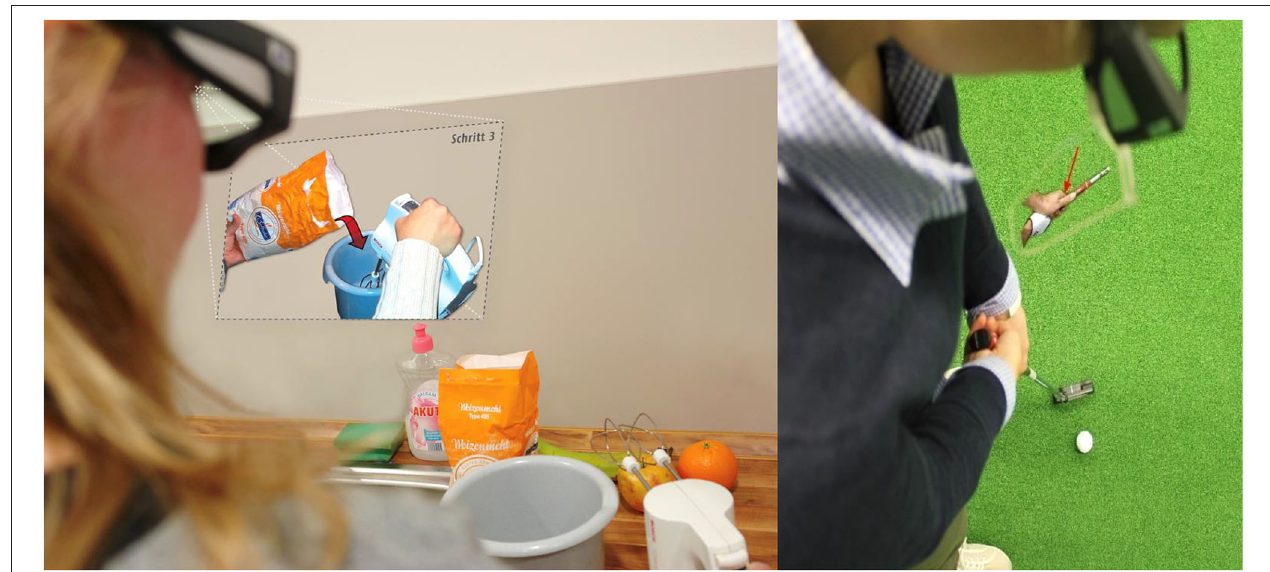
FIGURE 6 | Based on the measurement of mental representation structures, it is possible to learn about the expertise stage of the user and to provide individualized feedback (e.g., in a bakery or golf putting scenario). Photos: CITEC. Reproduced with permission of Thomas